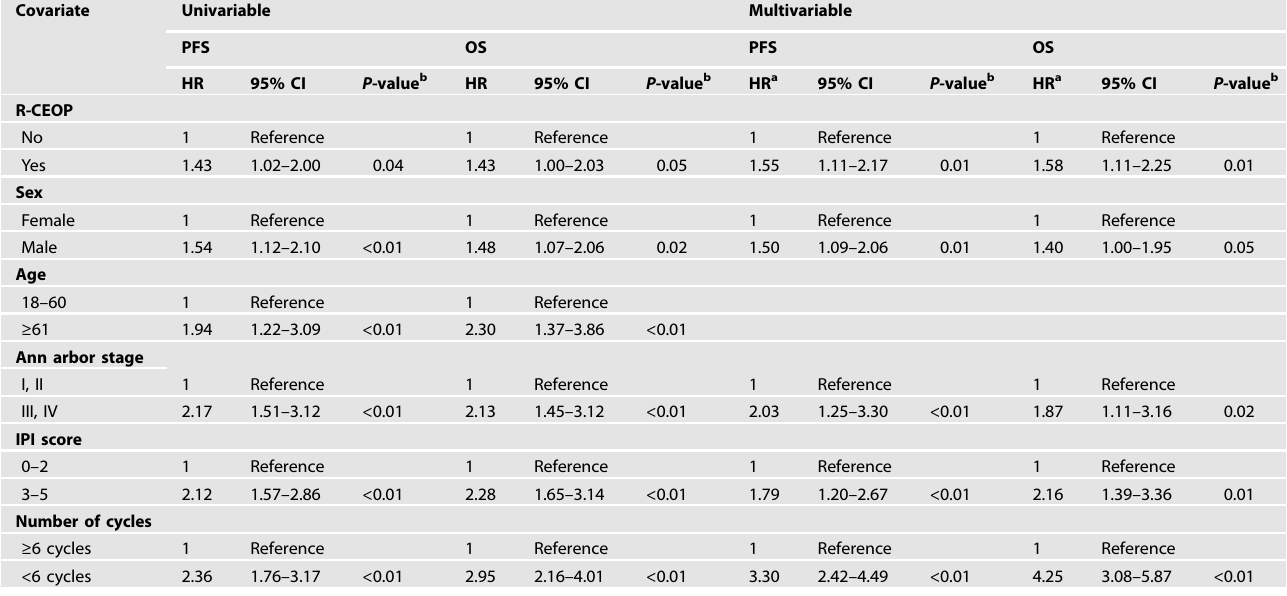
Table 2. Results of the uni- and multivariable Cox regression analysis on progression-free survival and overall survival for patient with diffuse large B-cell lymphoma treated with R-CEOP versus R-CHOP.